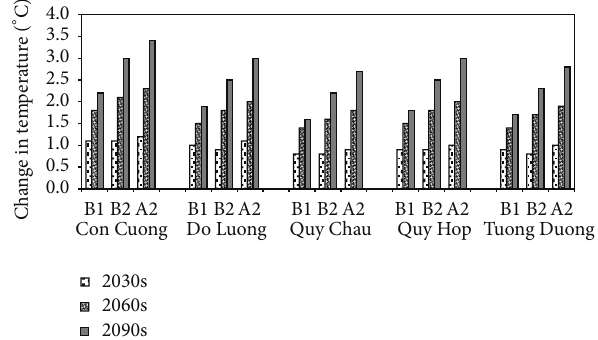
Figure 5: Relative change in mean annual temperature under 3 scenarios at 5 stations of the